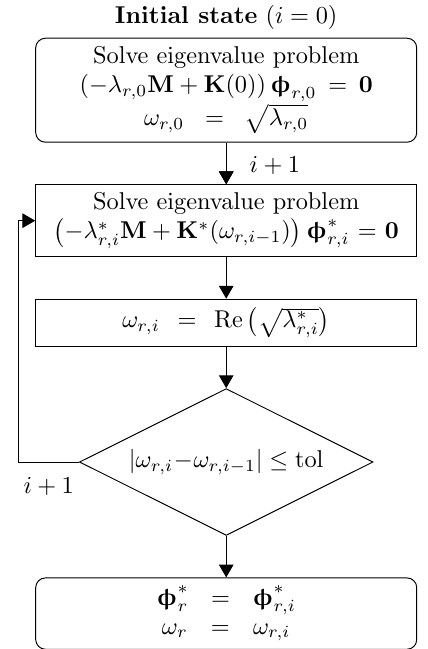
Figure 2. Algorithm to compute the eigenvalues and eigenvectors of the r th